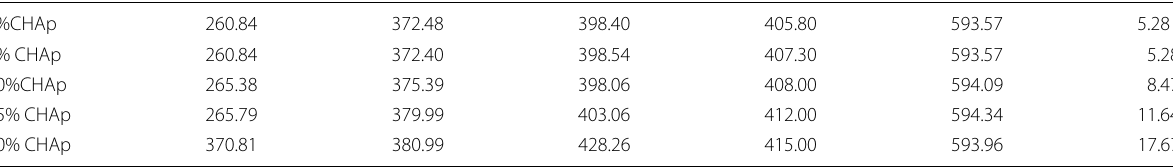
Table 4 Degradation temperatures of composites with CHAp